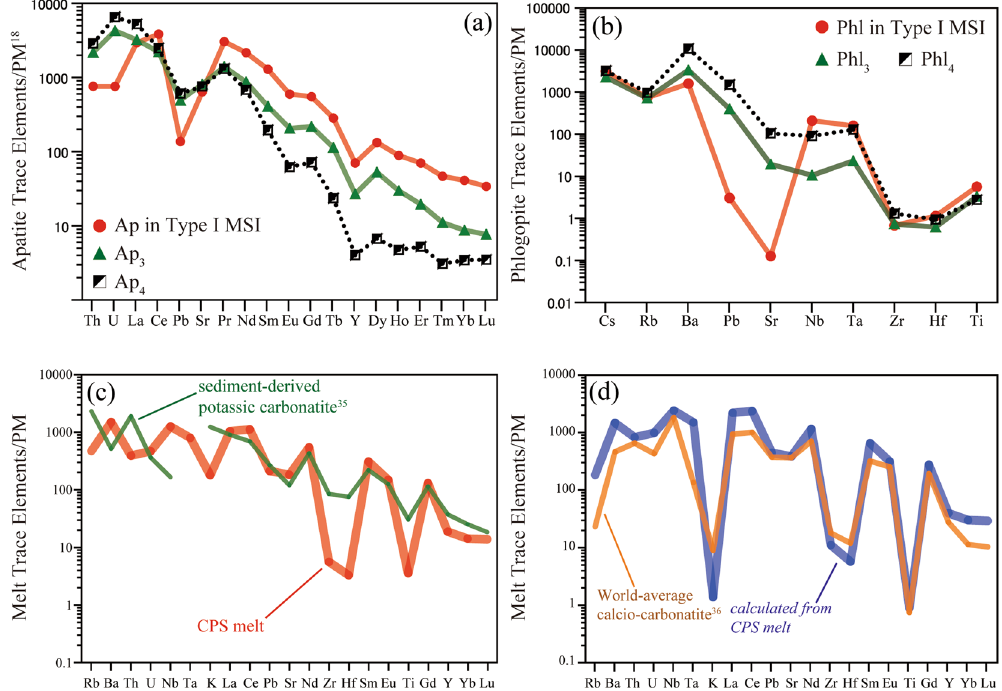
Figure 5. Panel (a) shows a trace element patterns of apatites (Aps), in which the subscripts indicate the crystallization stage, normalized to primitive mantle values 18 . MSI = multiphase solid inclusion. Panel (b) shows trace element patterns of phlogopites. Panel (c) displays a trace element pattern for a carbonated potassic silicate (CPS) melt calculated using trace elements in Ap and Phl within MSIs (Supplementary Table S2) in combination with appropriate partitioning coefficients for these minerals and carbonatite melts 33,34 . For comparison, the trace element patterns of a sediment-derived potassic carbonatite 35 are shown. Panel (d) shows a trace element pattern for a carbonatite that formed from the CPS melt by the precipitation of phlogopite. A trace element pattern for global average calcio-carbonatite 36 is shown for